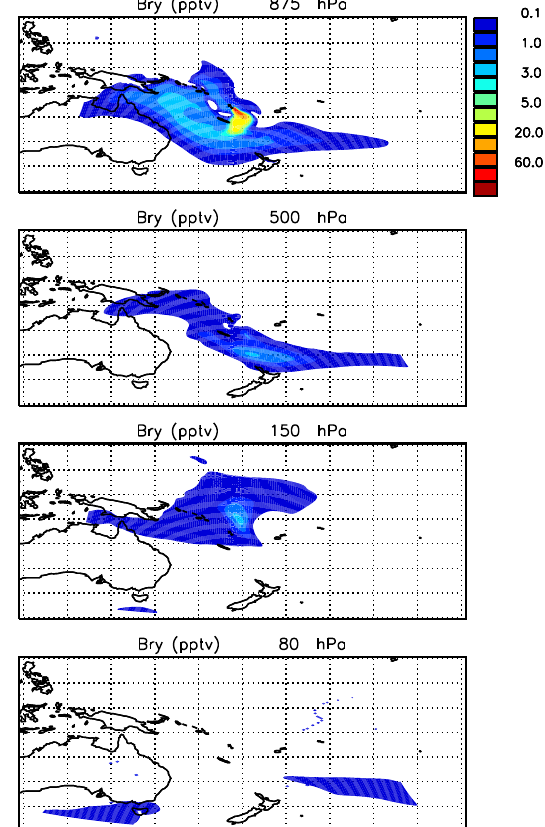
Figure 15. Daily mean difference (12 January 2005) between simu- lated Br y (pptv) in S1_HighT and in S0 at 875, 500, 150 and 80hPa for the 50km × 50km